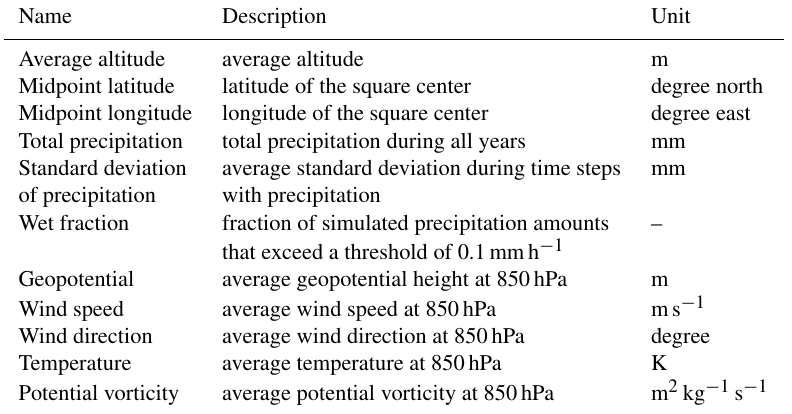
Table 2. Short description of the three precipitation events considered. Day Timeline Number of Description time